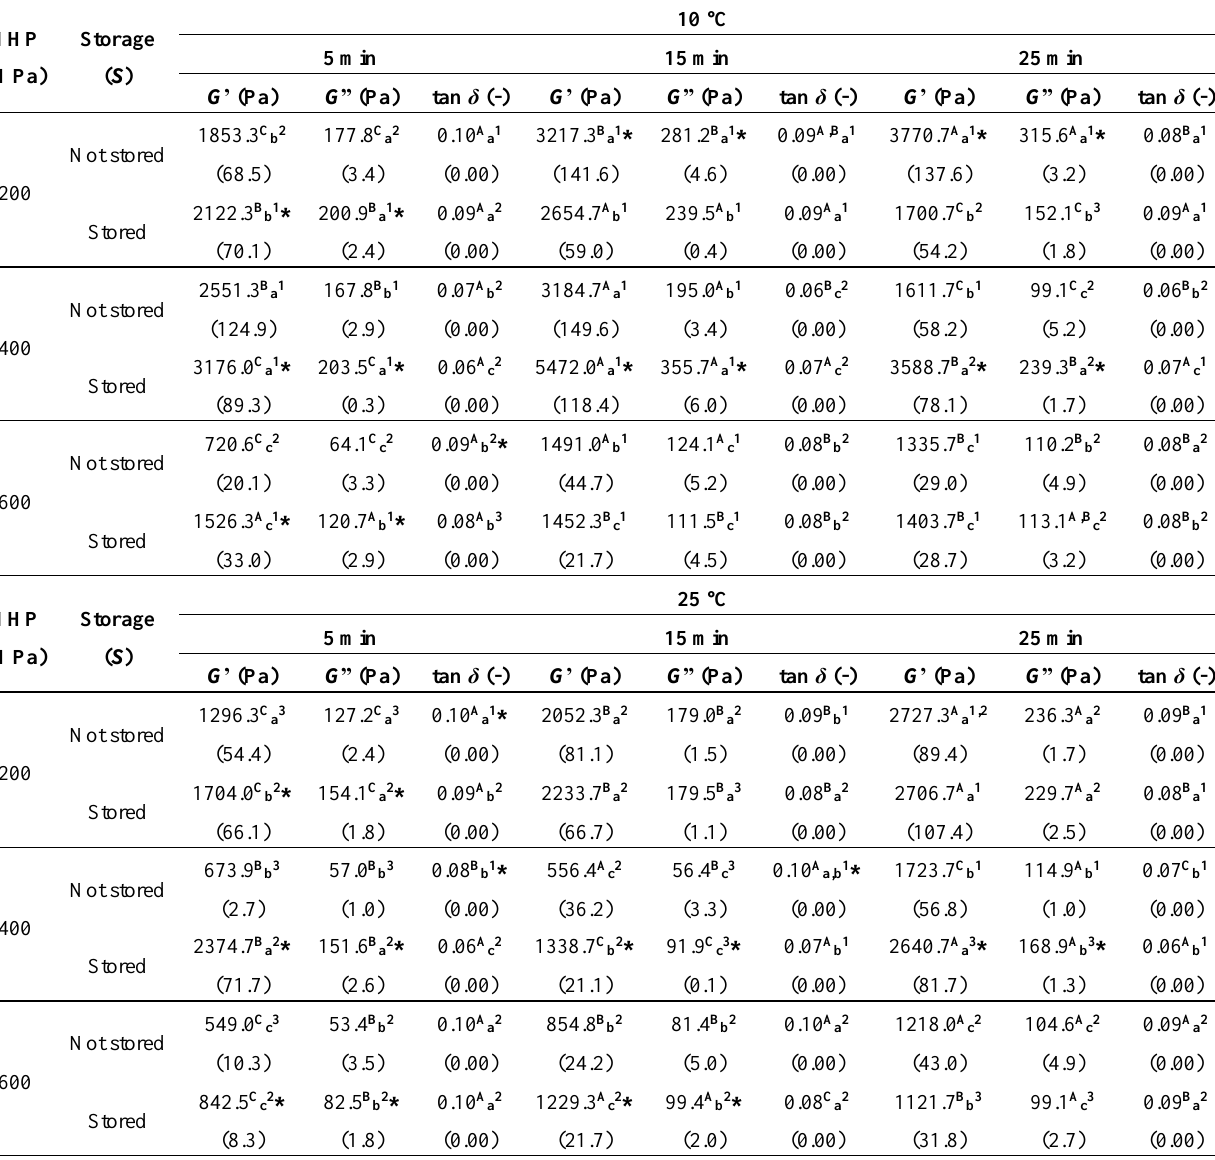
Table 2. Mean values of rheological properties ( G ’, G ”, and tan δ at 1 Hz) of chickpea flour gel heat-induced at 75 °C for 15 min derived from mechanical spectra after cooling to 25 °C in samples without and with storage for the different pressures (200, 400, and 600 MPa) and treatment temperatures (10 and 25 °C) applied for 5, 15, and 25 min, and for untreated